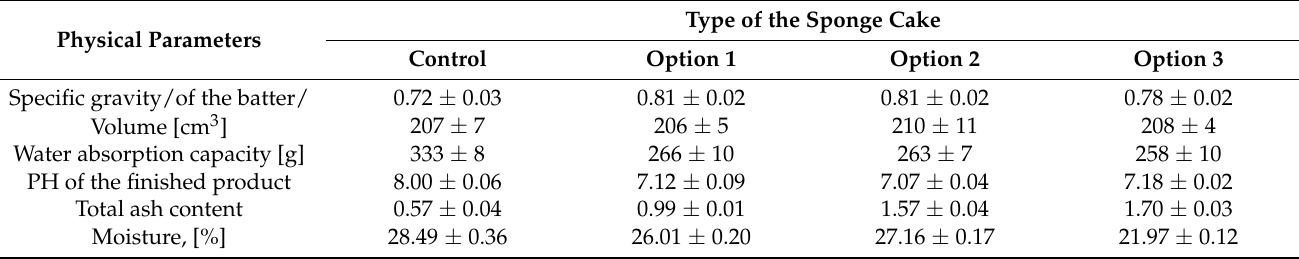
Table 2. Physicochemical characteristics of sponge cakes without and with dried Sambucus nigra L.